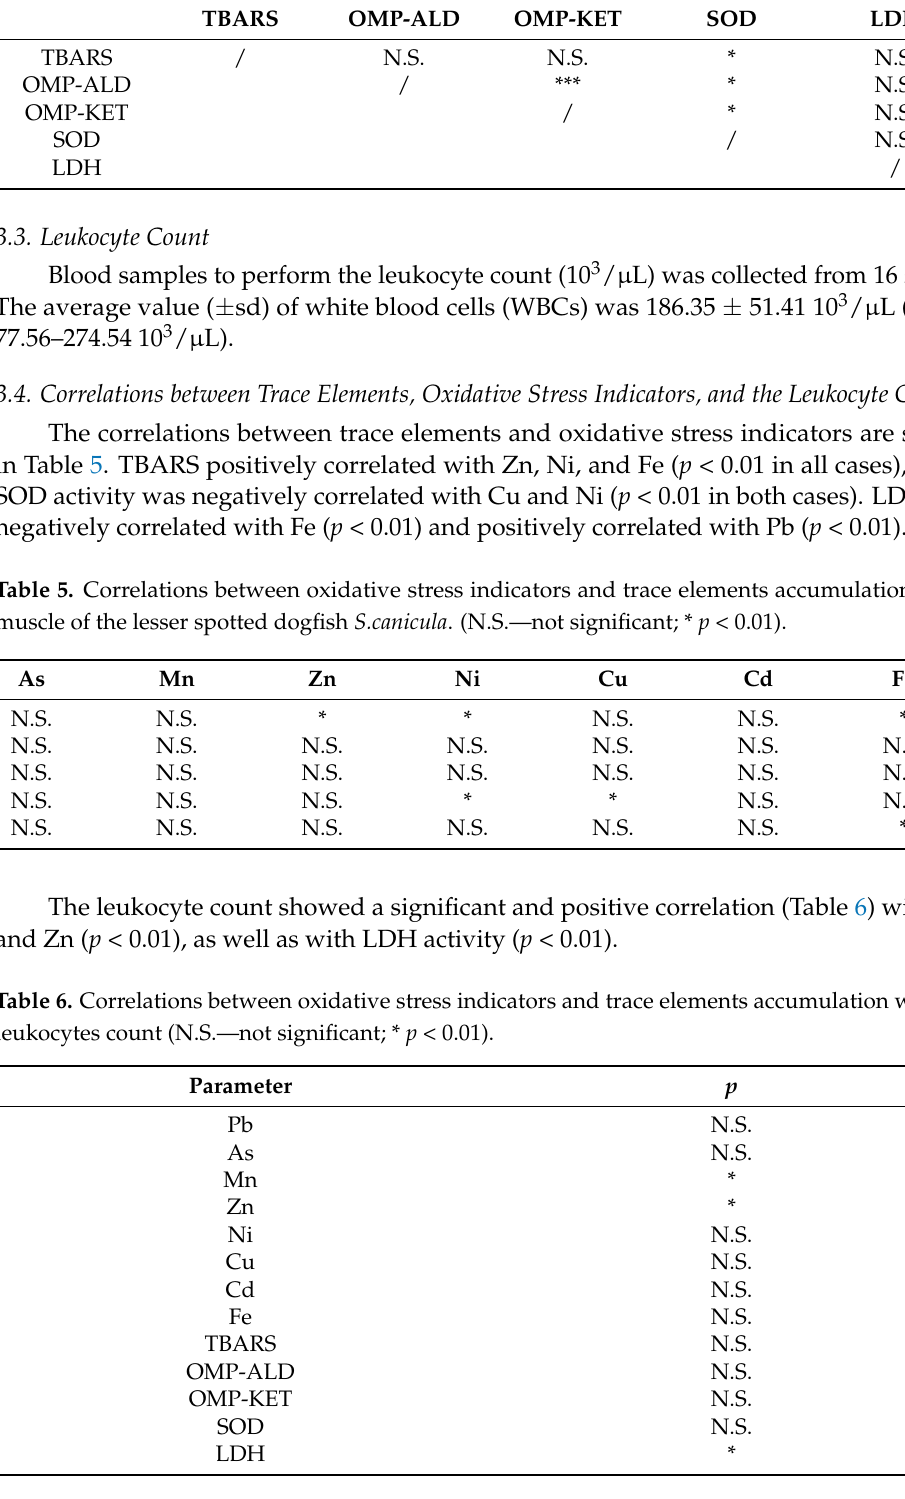
Table 4. Correlations between oxidative stress indicators in the muscle of the lesser spotted dogfish S. canicula . N.S.—not significant; * p < 0.01; *** p < 0.0001. TBARS OMP-ALD OMP-KET SOD LDH TBARS / N.S. N.S. * OMP-ALD / *** * OMP-KET / * N.S. SOD / N.S. LDH /